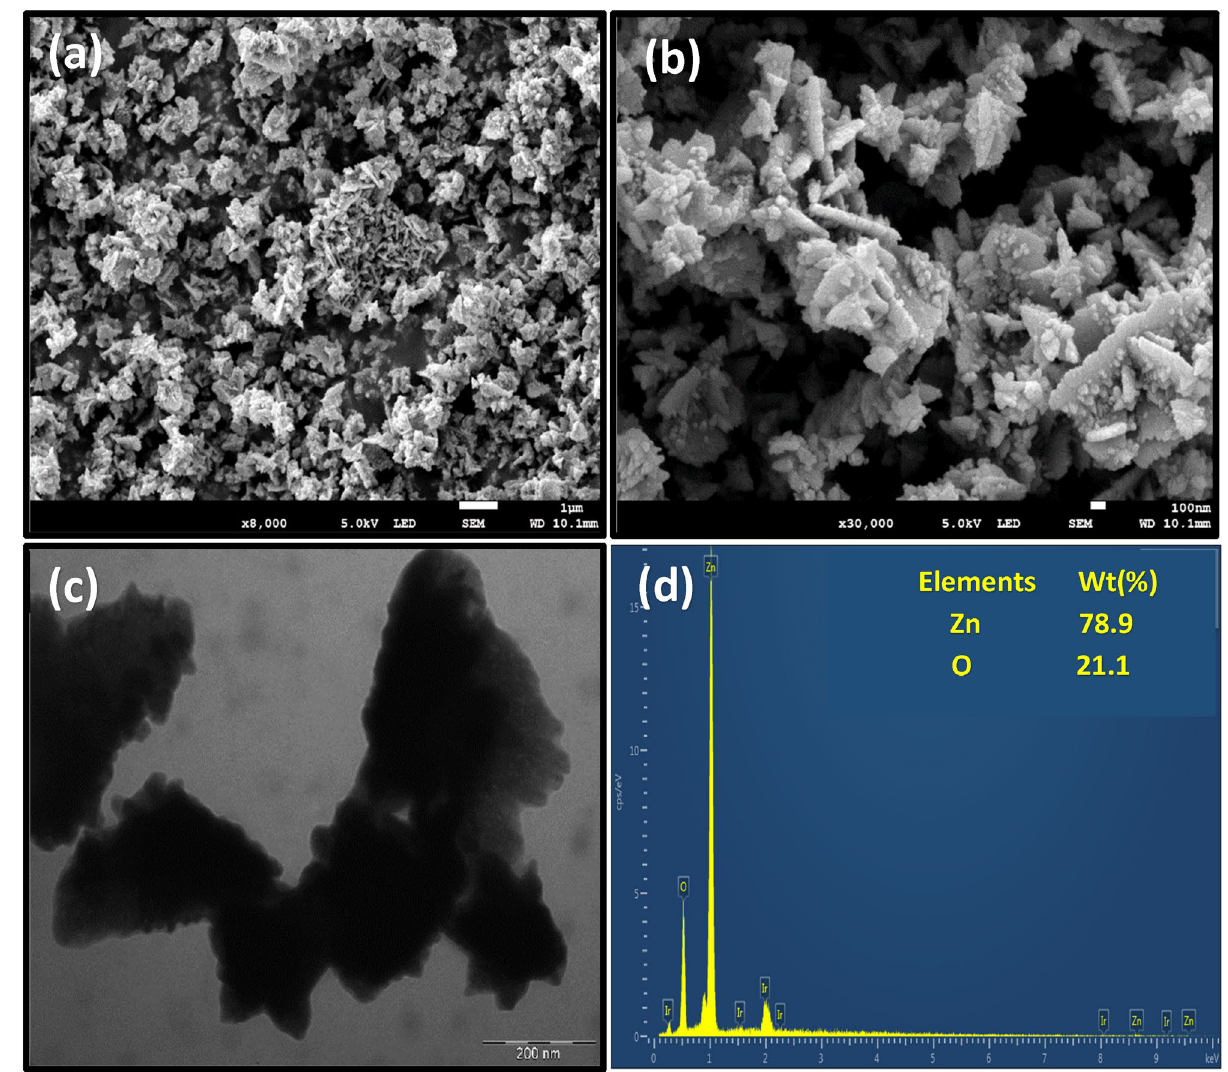
Figure 2. The ( a , b ) Scanning Electron microscopy ( c ) Transmission electron microscopy and ( d ) Energy dispersive X-ray spectrum of the synthesized